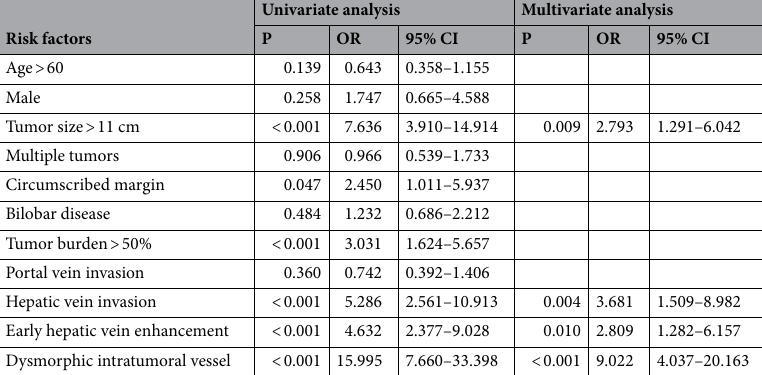
Table 2. Predictors for lung shunt fraction higher than